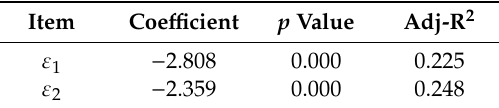
Table 5. The results of the Hausman